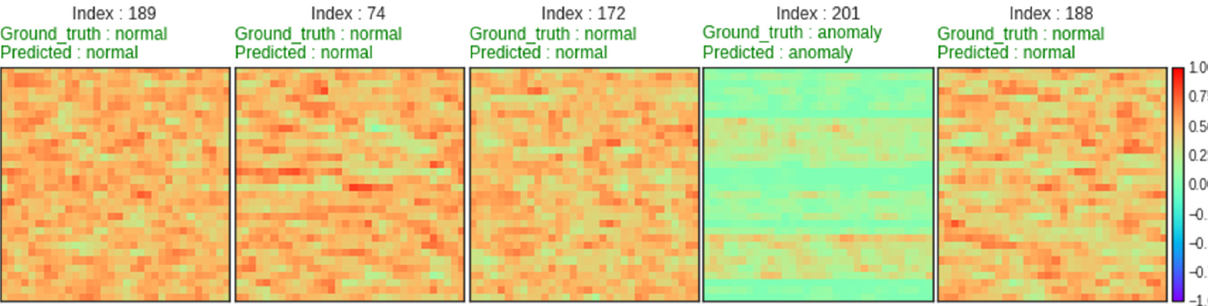
Figure 4. Slide rail data (16 K) DWT image encoding.